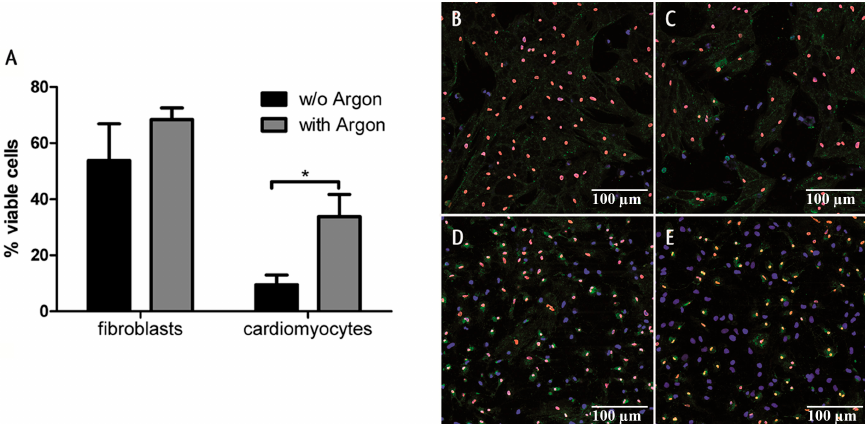
Figure 1. First and second window of preconditioning. Rat cardiac cells (200,000 cells/cm 2 ) were subjected either to 50% argon or room air for 1 h. Cells were then subjected to a sublethal dosage of hypoxia (<1% O 2 , 5% CO 2 , 95% N 2 ) for 5 h in the first ( A ) and second ( B ) window of preconditioning (directly after preconditioning or 24 h later). Cell survival was assessed via MTT assay 24 h after the ischemic insult and the viability was normalized to normoxic controls; ( C ) Cell proliferation was investigated 24 h after argon treatment using the green fluorescent nucleic acid stain CyQuant. Data represented means ± SEM (standard error of the mean) of three independent experiments for CyQuant and five independent experiments for MTT. *, p < 0.05.